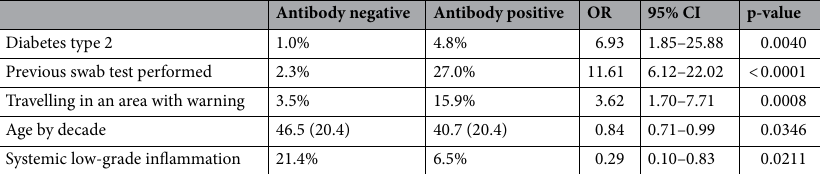
Table 4. Association of risk factors with SARS-CoV-2-specific antibody positivity. OR odds ratio, CI confidence interval.